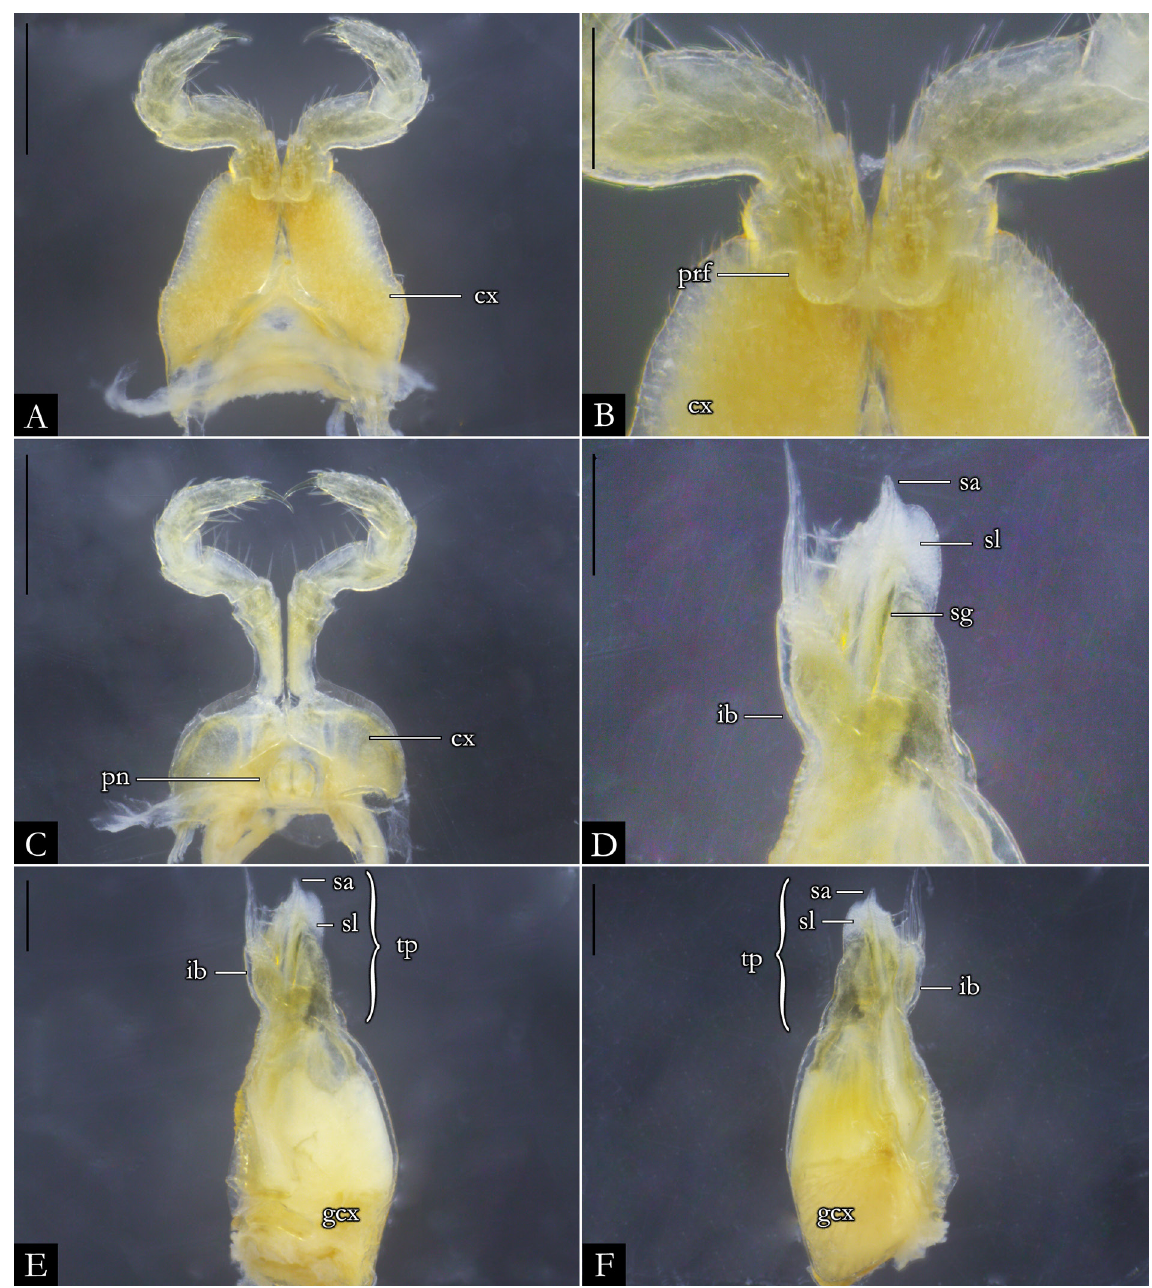
Fig. 45. Pseudonannolene alegrensis Silvestri, 1897, neotype, ♂ (MCN 626). A . First leg-pair. B . Detail of prefemur. C . Second leg-pair. D . Detail of telopodite, in anal view. E . Left gonopod, in anal view. F . Left gonopod, in oral view. Abbreviations: see Material and methods. Scale bars: A, C = 0.5 mm; B, D–F = 0.2